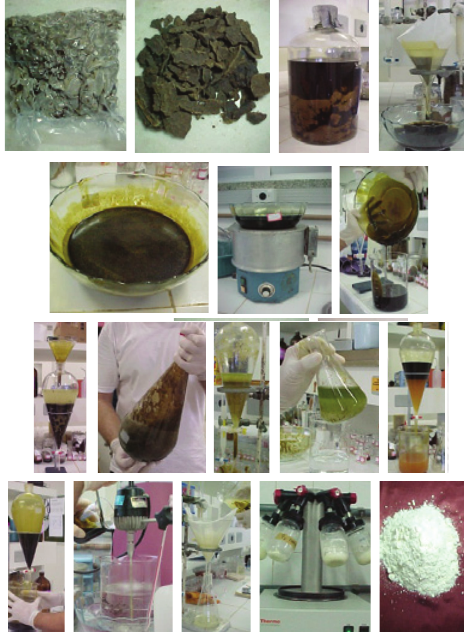
FIGURE 2 - Extraction of propolis (sequence of method of extraction of Water-Soluble Derivative of